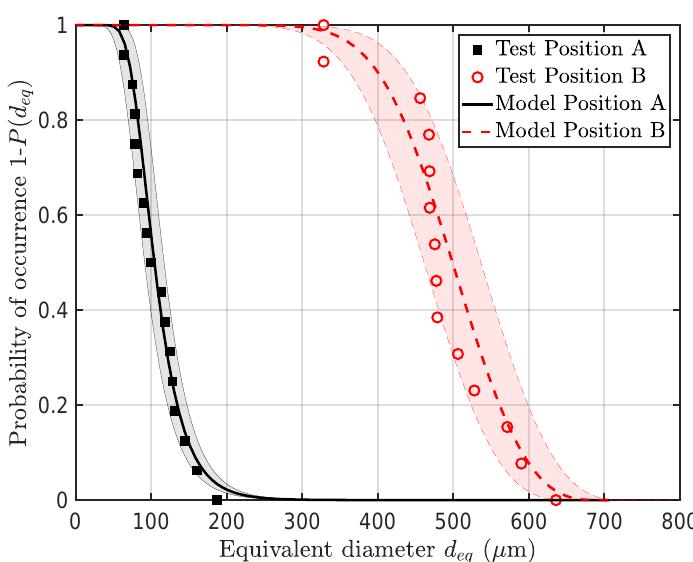
Figure 12. Probability of occurrence of defects depending on equivalent circle diameter d eq